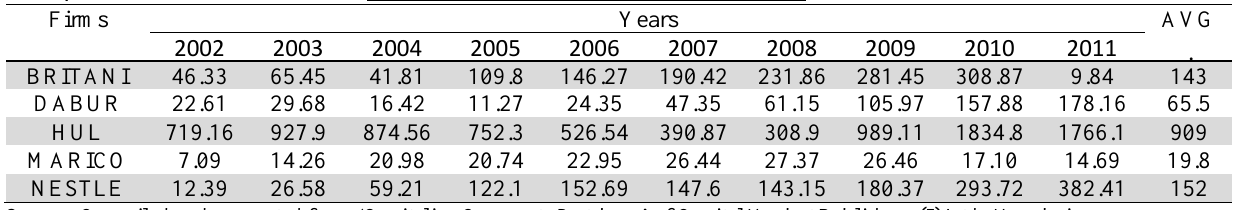
Analysis of Average Cash Holding (Avg. cash holding as percentage of total assets) of Selected Companies of FMCG sector Rs. in crore (also in % of total assets Firms Years